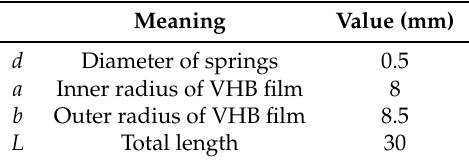
Table 1. Geometrical dimensions of proposed cylindrical